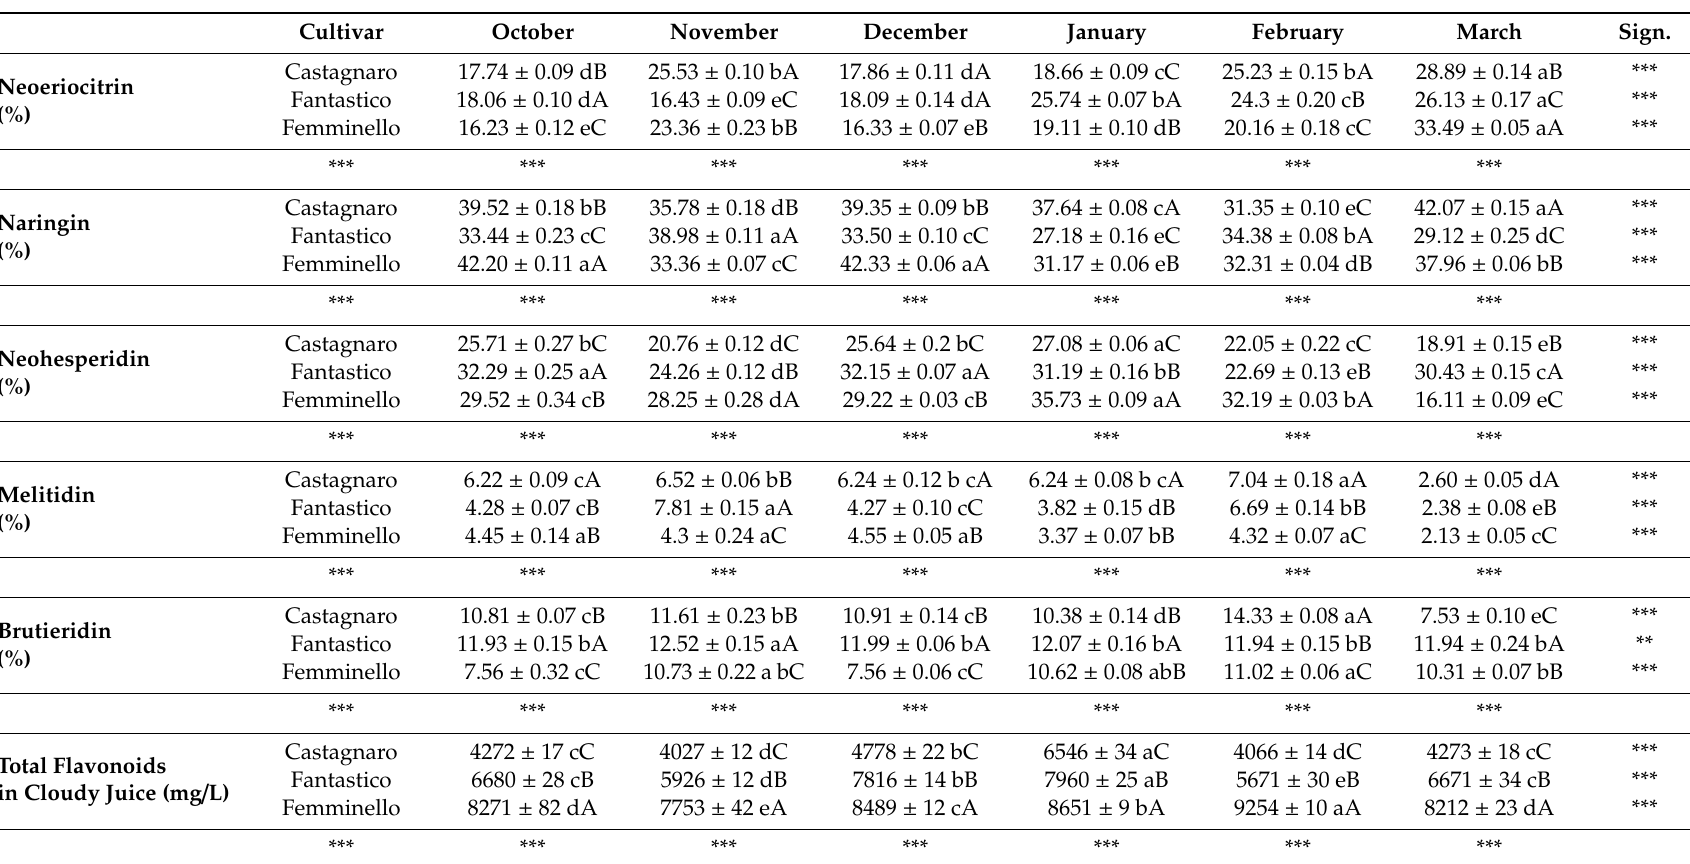
Table 7. Main flavonoids in the aqueous extract: cloudy juice. Results are presented as the mean value ± standard deviation, n = 8, (2016–2017 and 2017–2018 harvest years). *** significance at p < 0.001; ** significance at p < 0.01; * significance at p < 0.05. Means in the same line are distinguished by small letters. Means in the same column are distinguished by capital